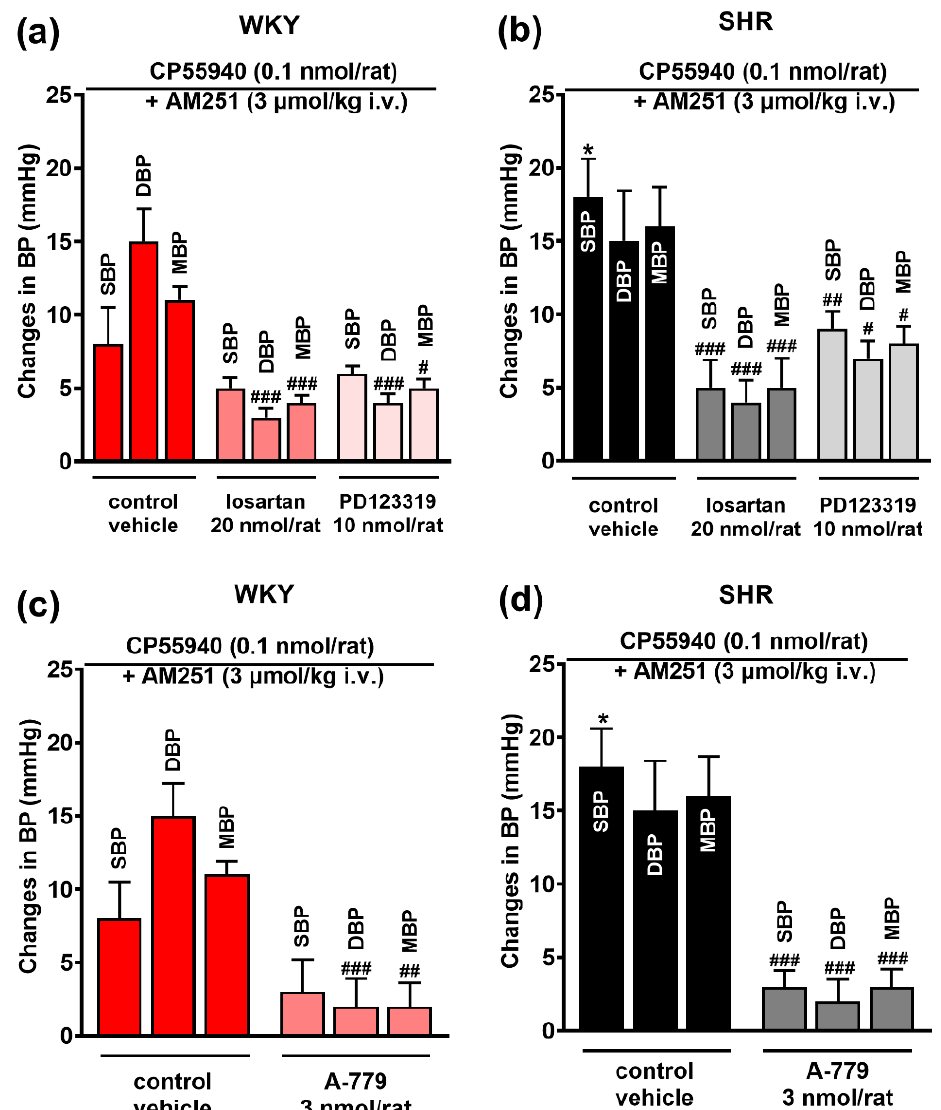
Figure 6. Influence of AT 1 and AT 2 (losartan and PD123319; ( a , b ), and Mas (A-779; ( c , d ) receptor antagonists on the pressor effect of the CB 1 receptor agonist CP55940 injected into the paraventricular nucleus of hypothalamus (PVN) in conscious Wistar Kyoto (WKY) and spontaneously hypertensive rats (SHR). All experiments were performed after i.v. injection of the CB 1 receptor antagonist AM251. Results, presented as mean ± SEM ( n = 5–7), are calculated as the change in basal values determined before agonist injection. # p < 0.05, # # p < 0.01, ## # p < 0.001 compared to the corresponding control group; * p < 0.05 compared to WKY.